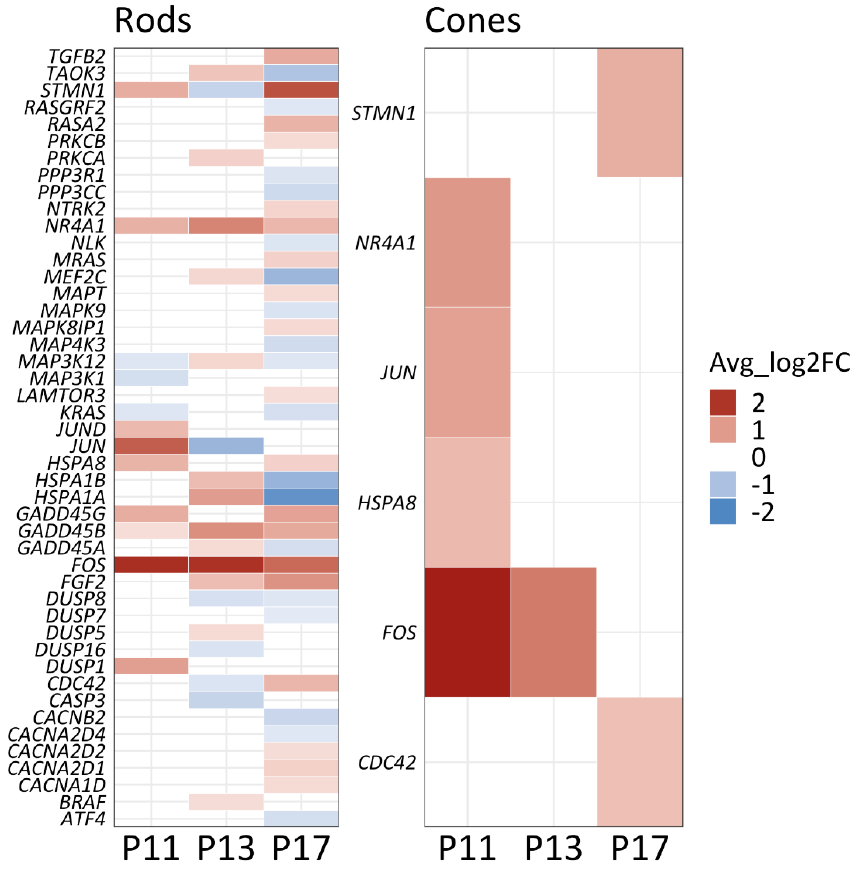
Figure 7. Transcriptional changes in MAPK-pathway related genes. Heatmap showing genes related to the MAPK gene set (MSigDB, gene set enrichment analysis) differentially expressed between wild − type and rd1 rod and cone photoreceptors ( p − value ≤ 0.5; |avg_log2FC| > 0.3) for the post- natal (P) day 11, P13, and P17 time − points. Blue indicates downregulated genes, red indicates upregulation. A total of 46 MAPK pathway genes were significantly altered in rods, whereas six genes were altered in cones.